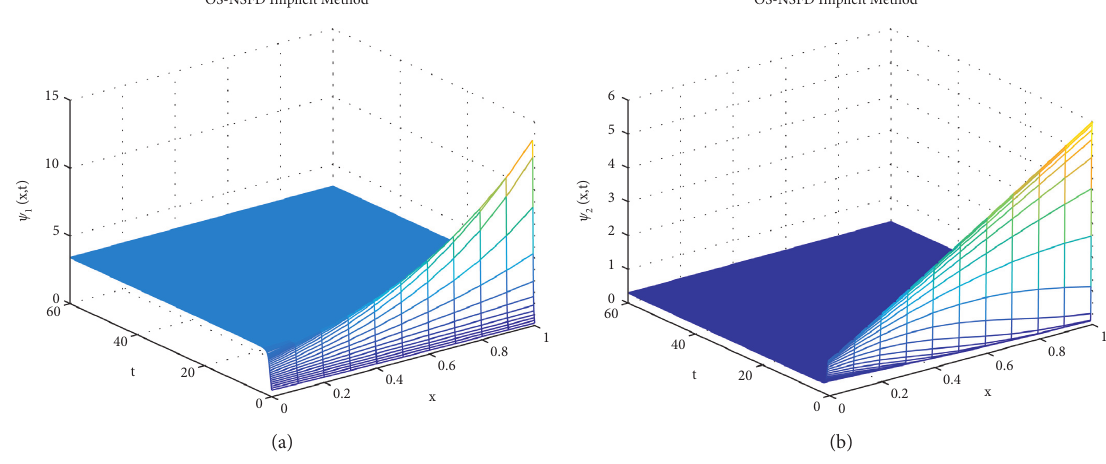
and ψ implementing NSFD explicit splitting technique 1 2